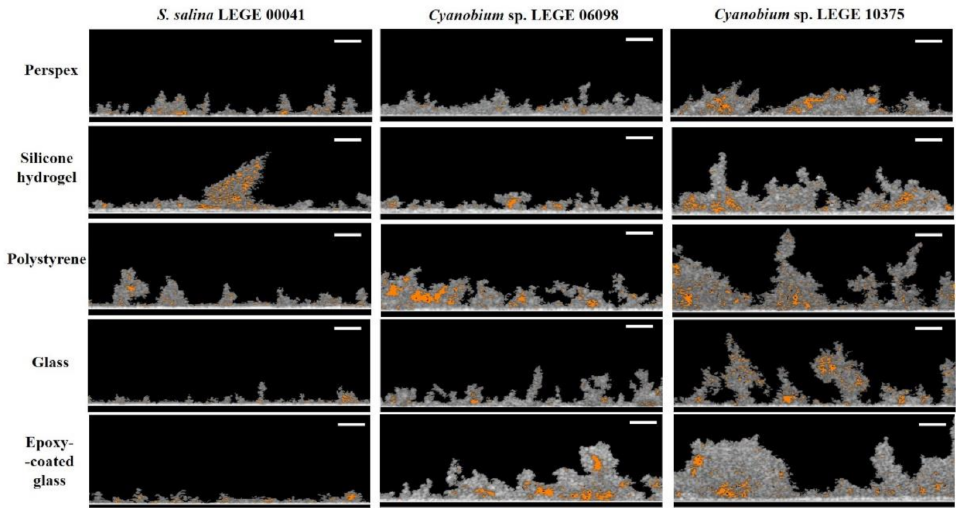
Figure 5. Representative 2D cross-sectional OCT images obtained for S. salina LEGE 00041, Cyanobium sp. LEGE 06098, and Cyanobium sp. LEGE 10375 biofilms formed on perspex, silicone hydrogel coating, polystyrene, glass, and epoxy-coated glass surfaces after 49 days. The empty spaces are indicated in orange (scale bars = 100 µ